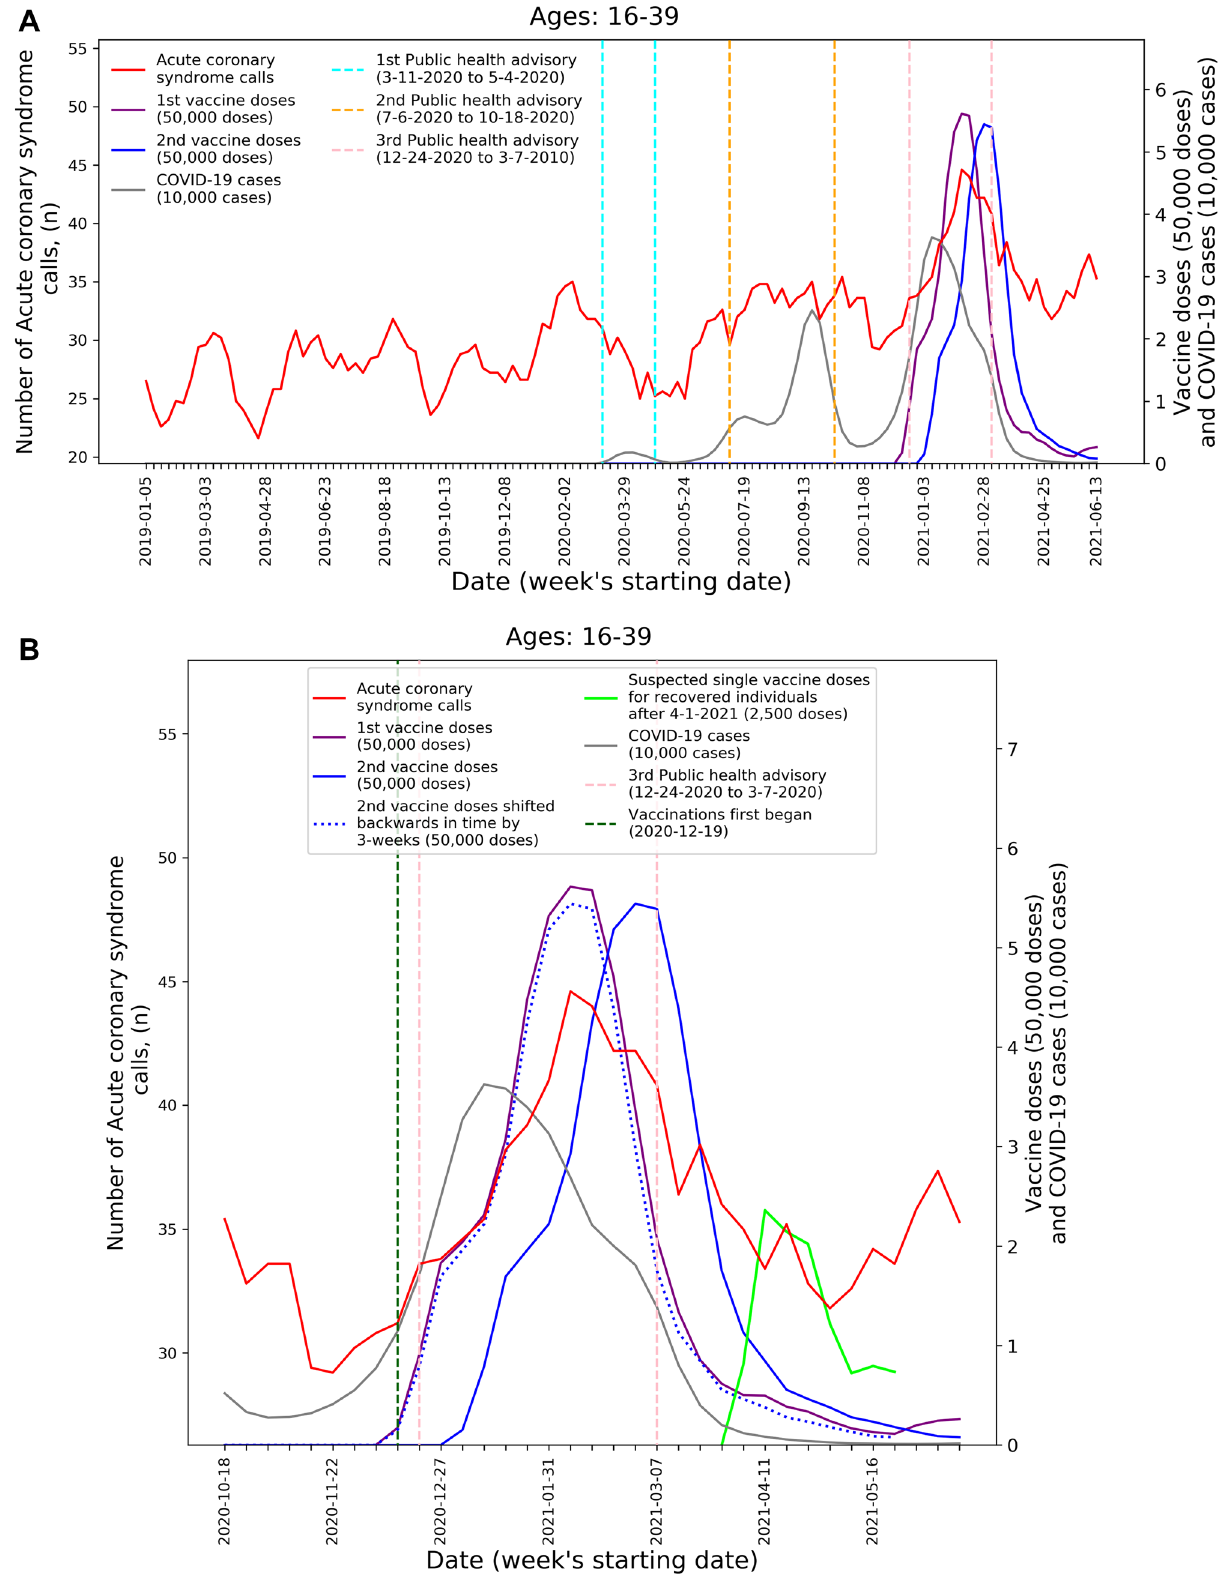
Figure 2. Weekly counts of acute coronary syndrome calls (five-week centered moving-average), COVID-19 cases (three-week centered moving-average), and vaccination doses (three-week centered moving-average) for those between 16 and 39 during: A) the study period (January 1st, 2019, to June 20th, 2021) and B) the third COVID-19 wave and vaccination distribution period (October 18th, 2020, to June 20th, 2021). COVID‑19 Coronavirus disease